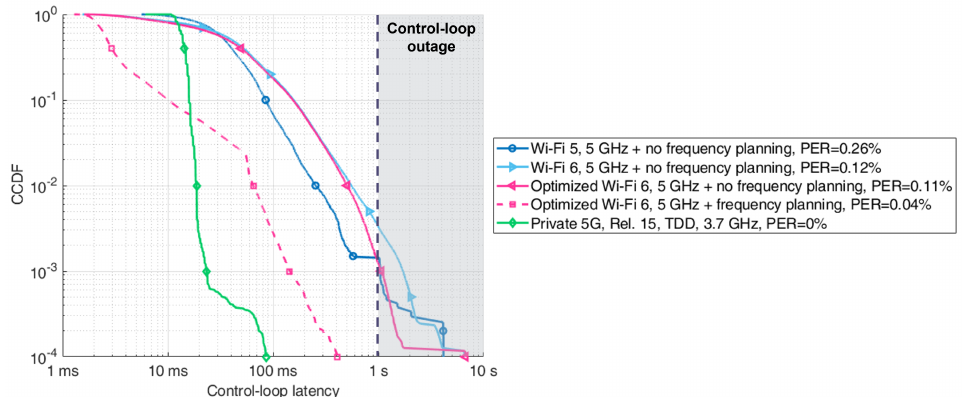
Figure 10. CCDF of the AMR-FM control-loop latencies for the different Wi-Fi and 5G network configuration explored in the performance measurement